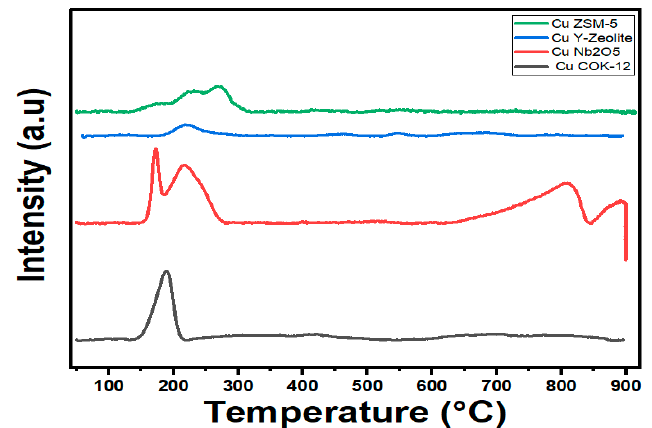
Figure 8. TPR profiles of Cu-modified ZSM5, Nb2O5, COK12, and Y-Zeolite catalysts .